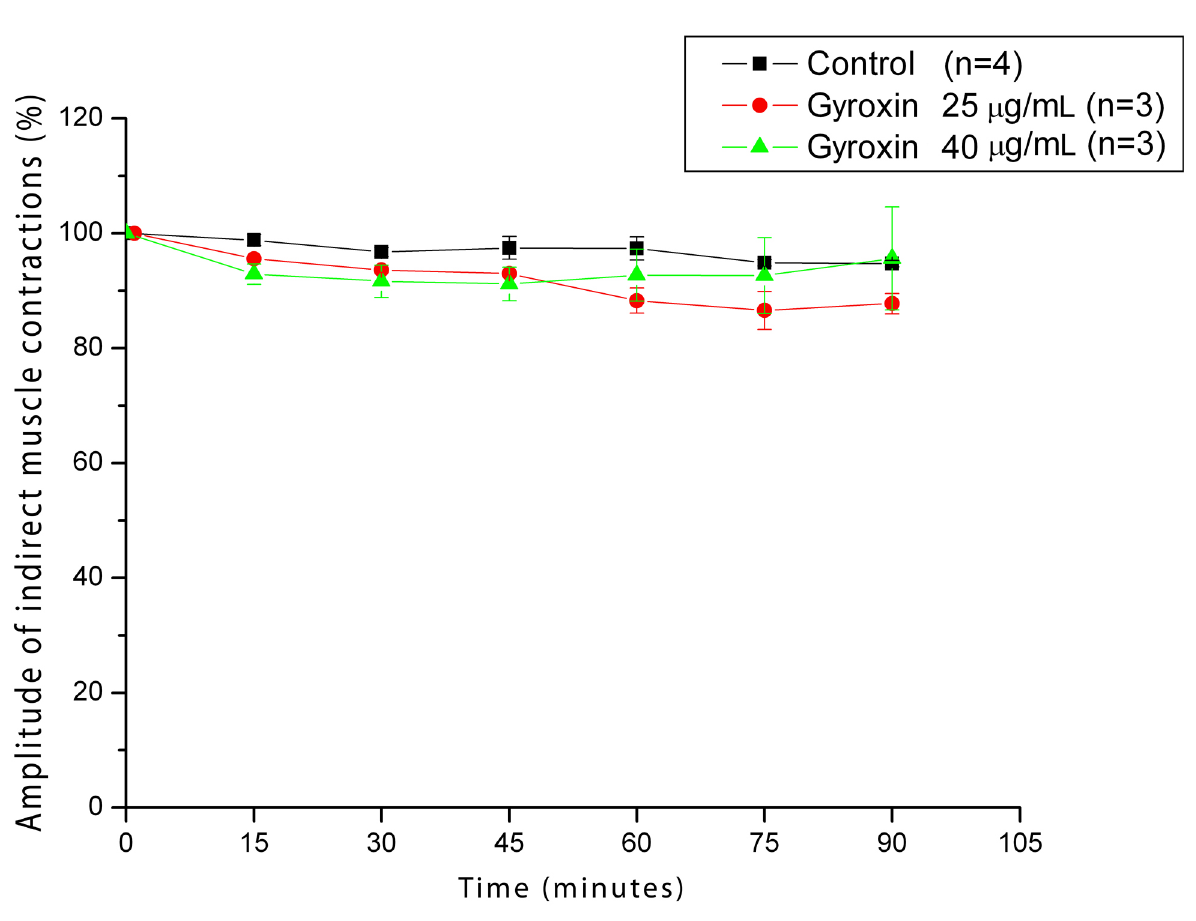
Figure 3. Effects of gyroxin on indirectly evoked twitches in mouse phrenic-diaphragm preparations. The ordinate represents the amplitude percentage (%) of twitches relative to the initial amplitude. The abscissa indicates the time (minutes) after the addition of gyroxin to the organ bath. The results indicate no significant differences produced by gyroxin at 25 µg/mL or gyroxin at 40 µg/mL in relation to control (p ≤